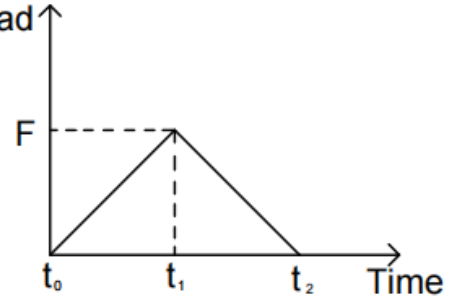
Figure 6. The approximate simulation of vehicle loads as triangular loads.